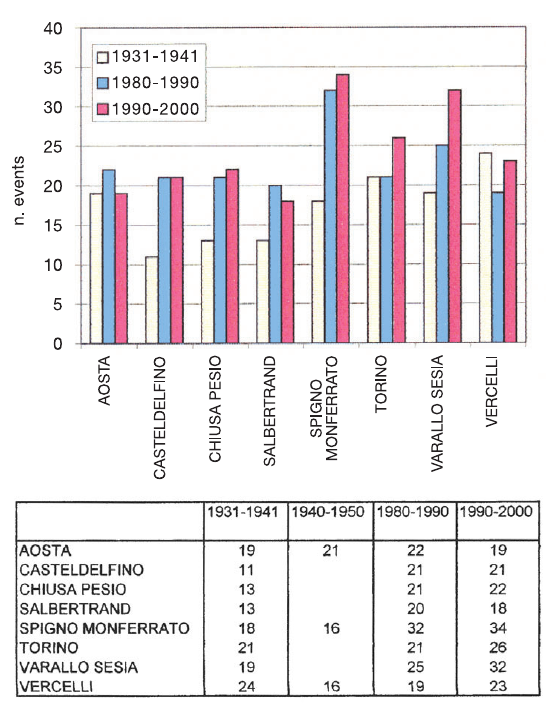
Fig. 5. Number of events of 48 h with NII different from